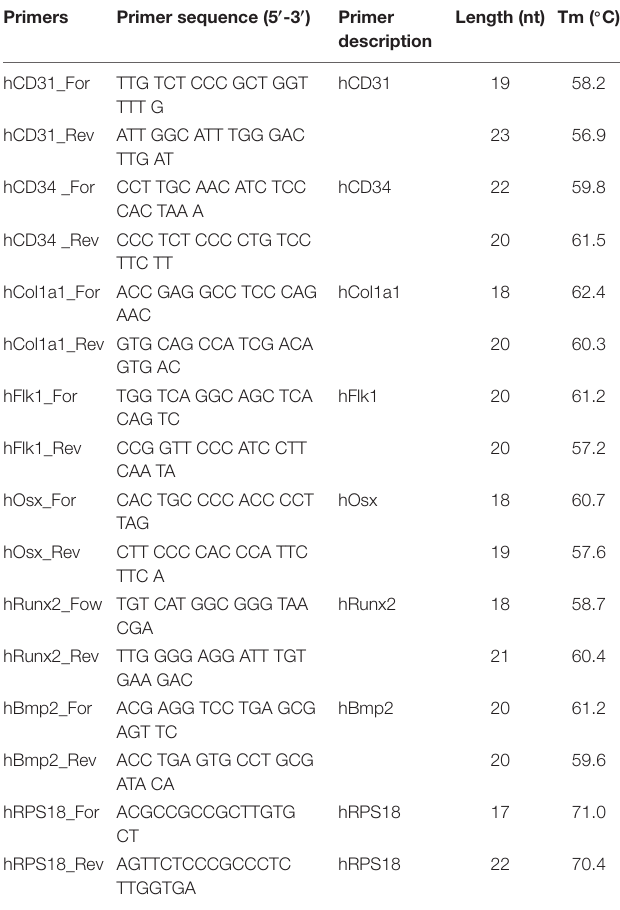
TABLE 1 | List of primers used in the research.